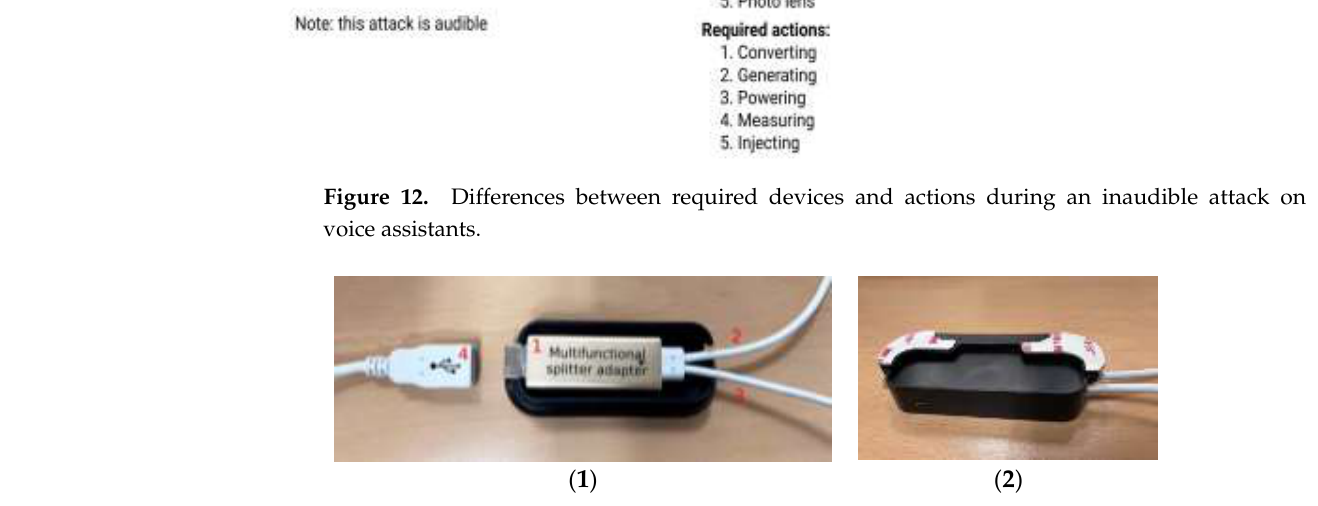
Figure 13. A connected multifunctional splitter adapter for transmitting audio through the headset and charging connected smartphones.